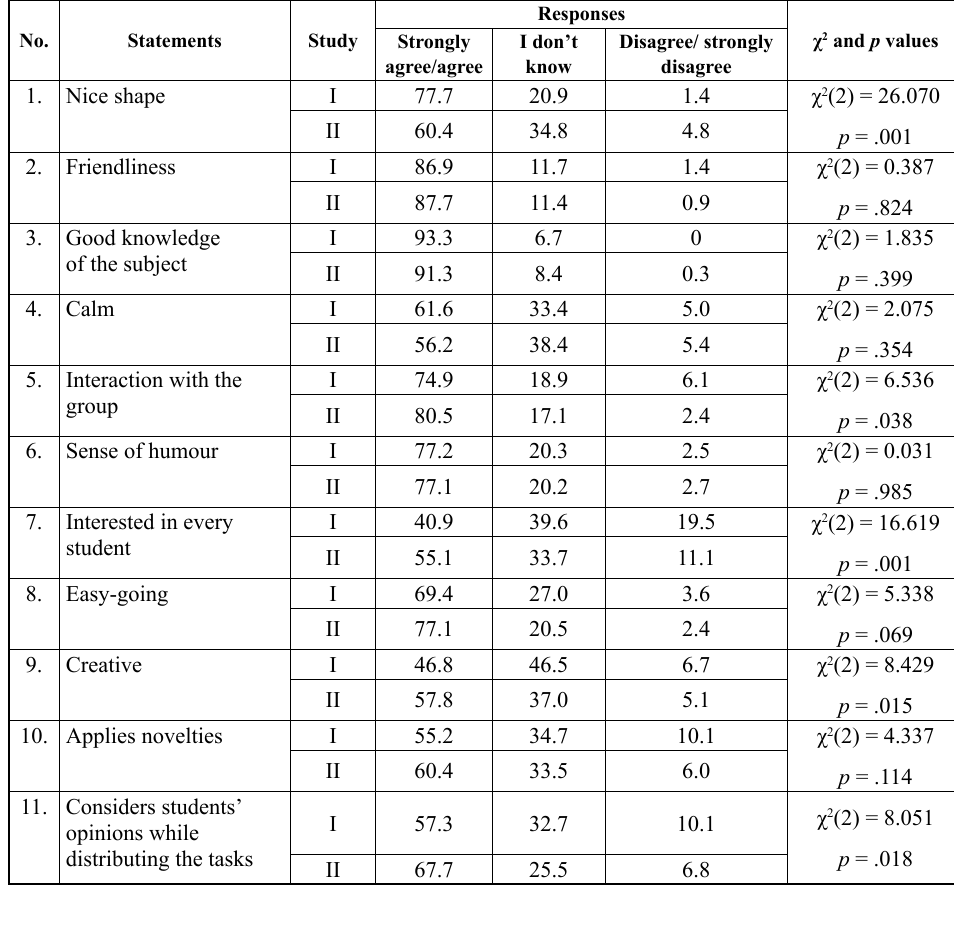
Table 3. Male stu- dents’ responses to the question “What traits of the